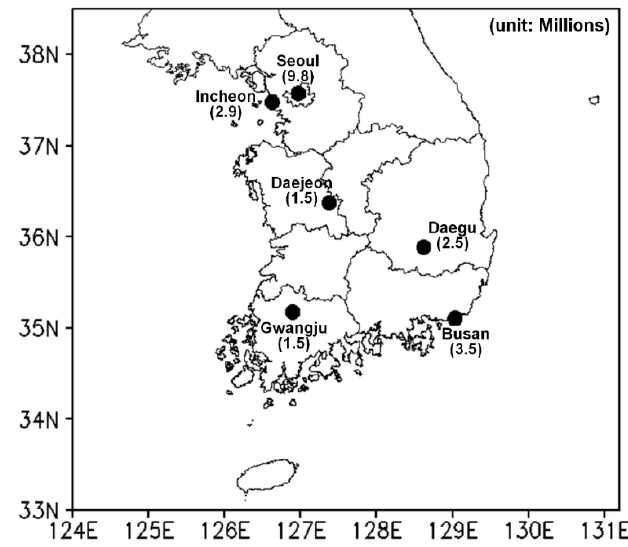
Figure 1. Locations and populations of the six metropolitan cities in South Korea.